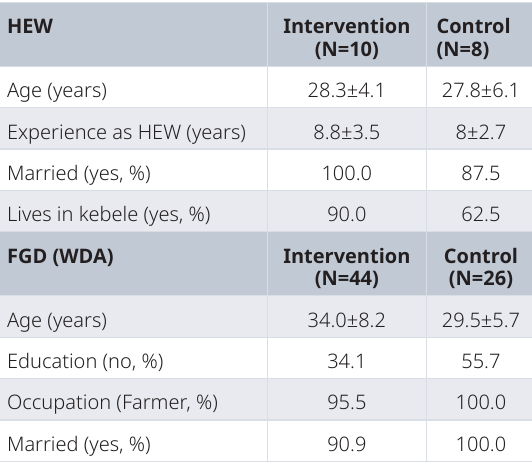
Table 1. Characteristics of study